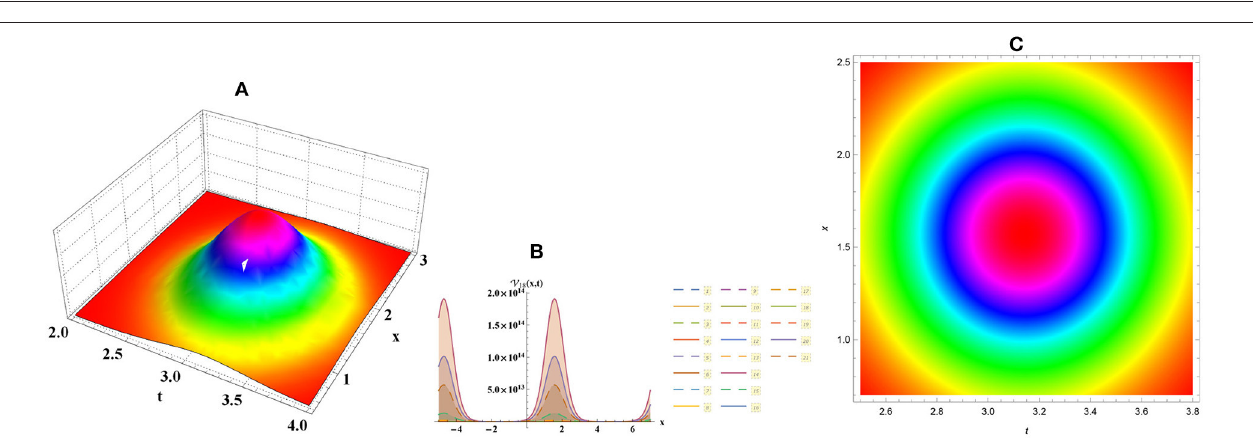
Frontiers in Physics |